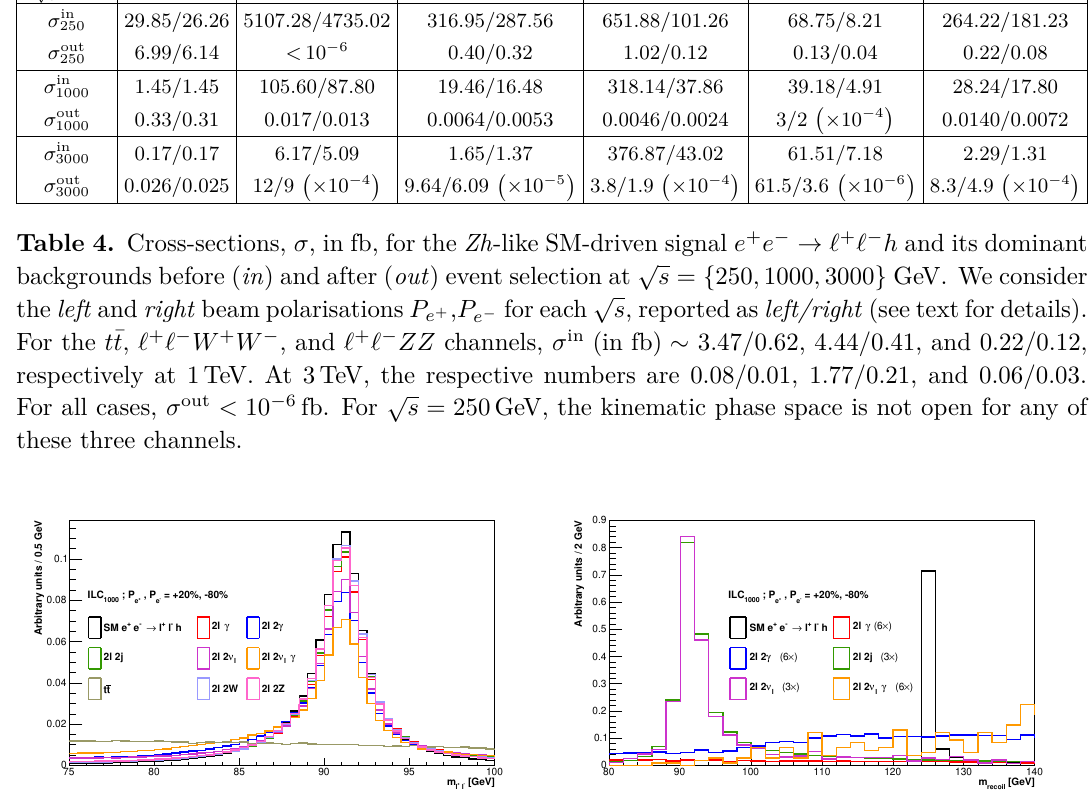
∈ [86 . 0 , 96 . 0] GeV cut. ‘ + ‘ −